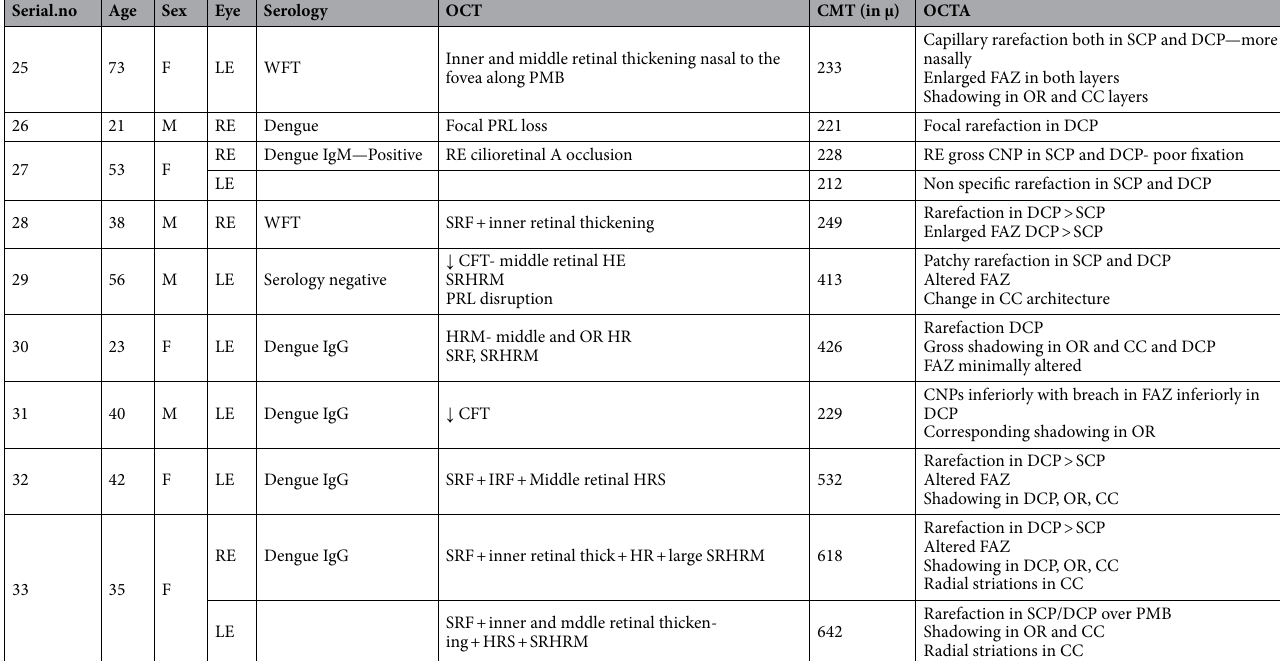
Table 1. Shows demographic, aetiological and descriptive characteristics in patients with post fever retinitis. M Male, F Female, RE Right eye, LE Left eye, WFT Weil Felix Test, OCT Optical Coherence